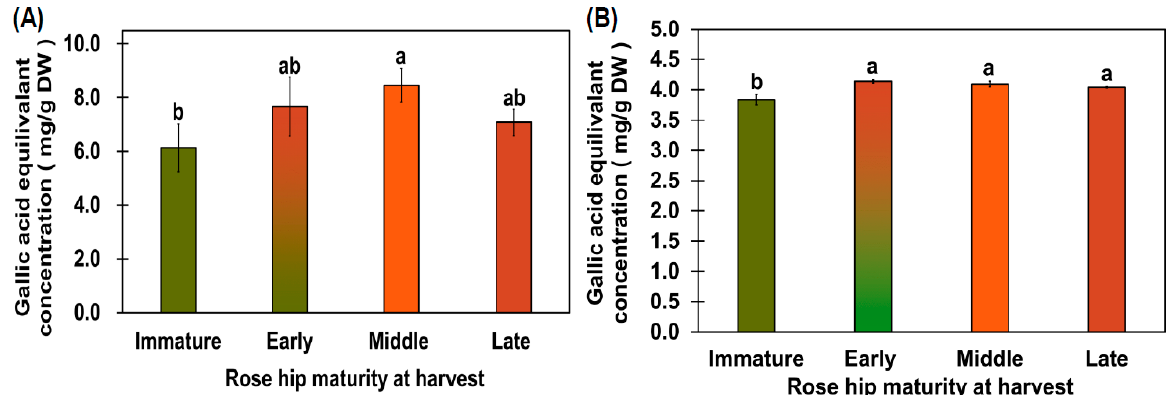
Figure 3. TPC ( A ) and DPPH capacity ( B ). TPC ( A ) and DPPH antioxidant capacity ( B ) were measured as gallic acid equivalents. The TPC of the 70% rose hip ethanol extract was measured at 715 nm using Folin–Cioc â lteu phenol reagent, whereas antioxidant activity was measured using 70% rose hip ethanol extract at 515 nm. Different letters above the error bars indicate significant differences according to Tukey’s HSD test ( p < 0.05).